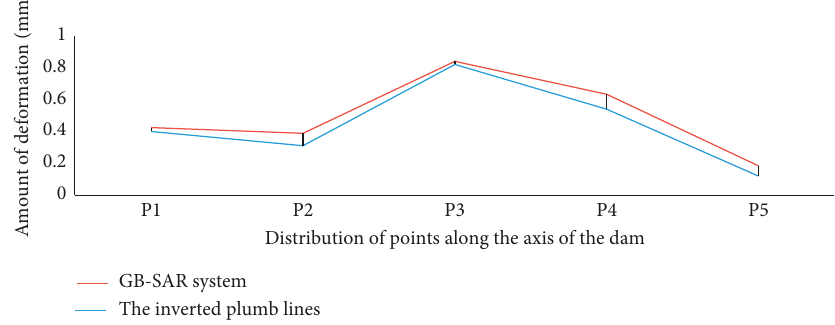
Figure 21: Spatial distribution of the amount of deformation of the top of the Table 5: GB-SAR deformation rate error statistics. Measuring point